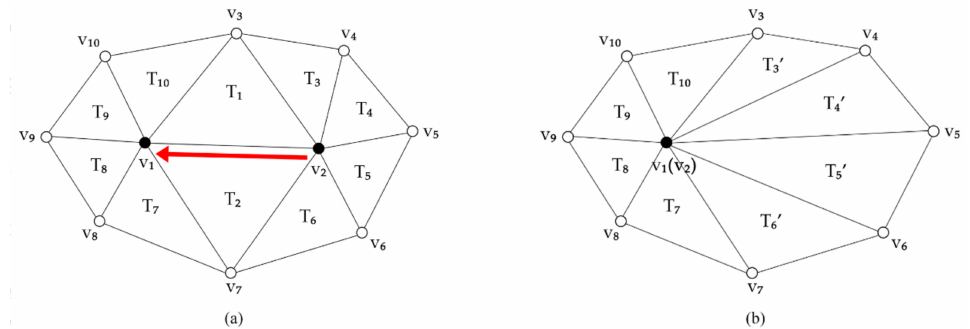
Figure 4. Diagram of the triangle information changes during edge collapse. ( a , b ) represent the mesh, before and after edge collapse,